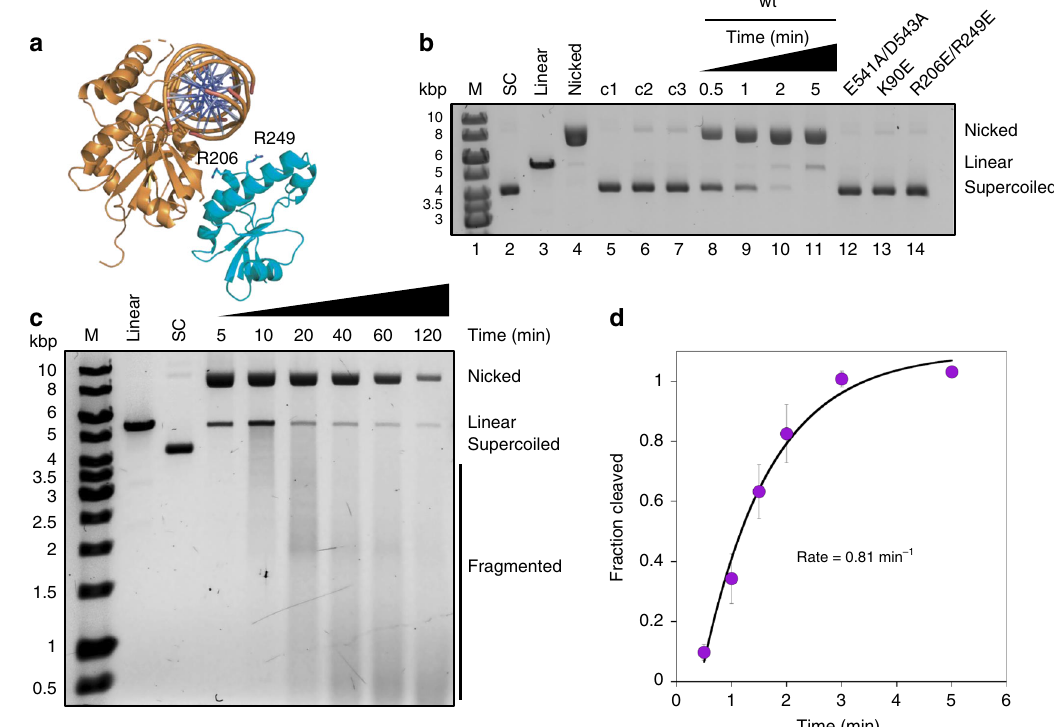
Fig. 4 Can1 nicks supercoiled plasmid when activated by cA 4 in the presence of MnCl 2 . a The nuclease domain of Can1 (orange) in complex with the modelled position of dsDNA (based on homologous structures, the nuclease domains of Age I (PDB: 5DWB) and Ngo MIV (PDB: 1FIU)). The nuclease-like domain of Can1 is shown in cyan and Arg206 and Arg249 are shown as sticks. b Native agarose gel analysis of plasmid (2 nM) cleavage by Can1 (200 nM), showing rapid nicking in the presence of cA 4 (200 nM) and MnCl 2 (5 mM) (lanes 8-11). Standards corresponding to supercoiled, linear and partially nicked plasmid are shown in lanes 2-4. Lanes 5-7 show the reactions incubated for 5 min without protein (c1), MnCl 2 (c2) or cA 4 (c3), respectively. Can1 variants E541A/D543A, K90E and R206E/R249E generate minimal nicked product after 5 min (lanes 12-14). M — DNA size markers. c Extended time course of plasmid degradation by Can1. Rapid nicking is followed by slower degradation to small linear products over 2 h. Standards are as described in part are the mean of triplicate experiments with the standard deviation shown. Source data are provided as a ‘ Source Data ’ fi